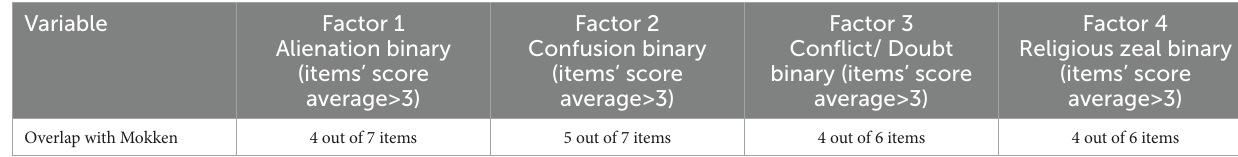
TABLE 3 Comparison of EFA factors and MSA sub-domains.